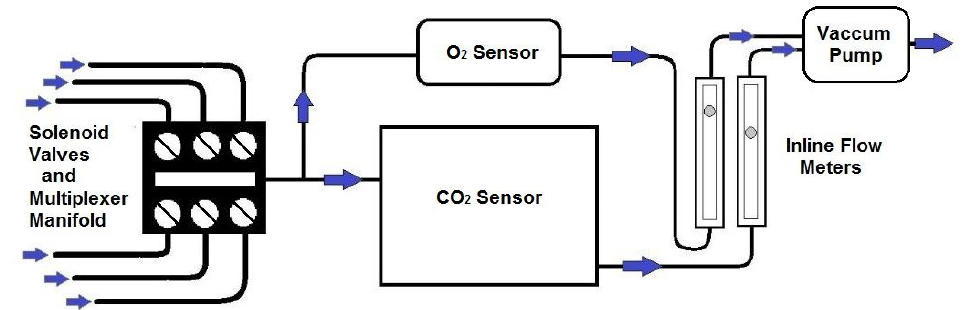
and O gas sampling concentration 2 2